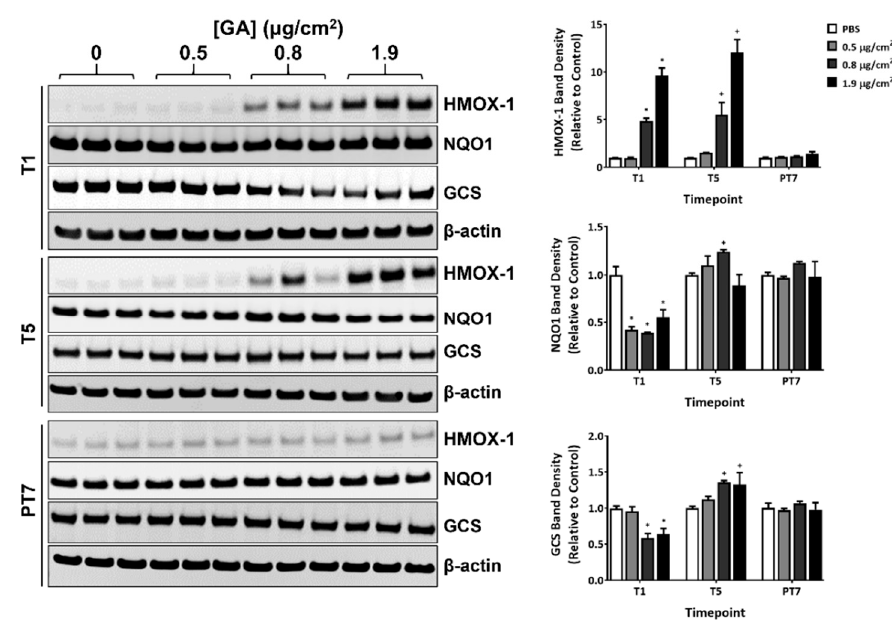
Figure 4. Modulation of the expression of oxidative stress markers by GA aerosols. Protein expression of HMOX-1, NQO1, and GCS was measured at T1, T5, and PT7 by immunoblotting. β -actin was used as the internal loading control for normalizing the expression of these proteins. Representative immunoblots are shown in the left panel. Quantification of the protein relative to the PBS- exposed vehicle controls is presented in the right panel. Data ( n = 3) are expressed as means ± SEM. * ,+ p <0.05 was considered statistically significant compared to the respective vehicle controls.